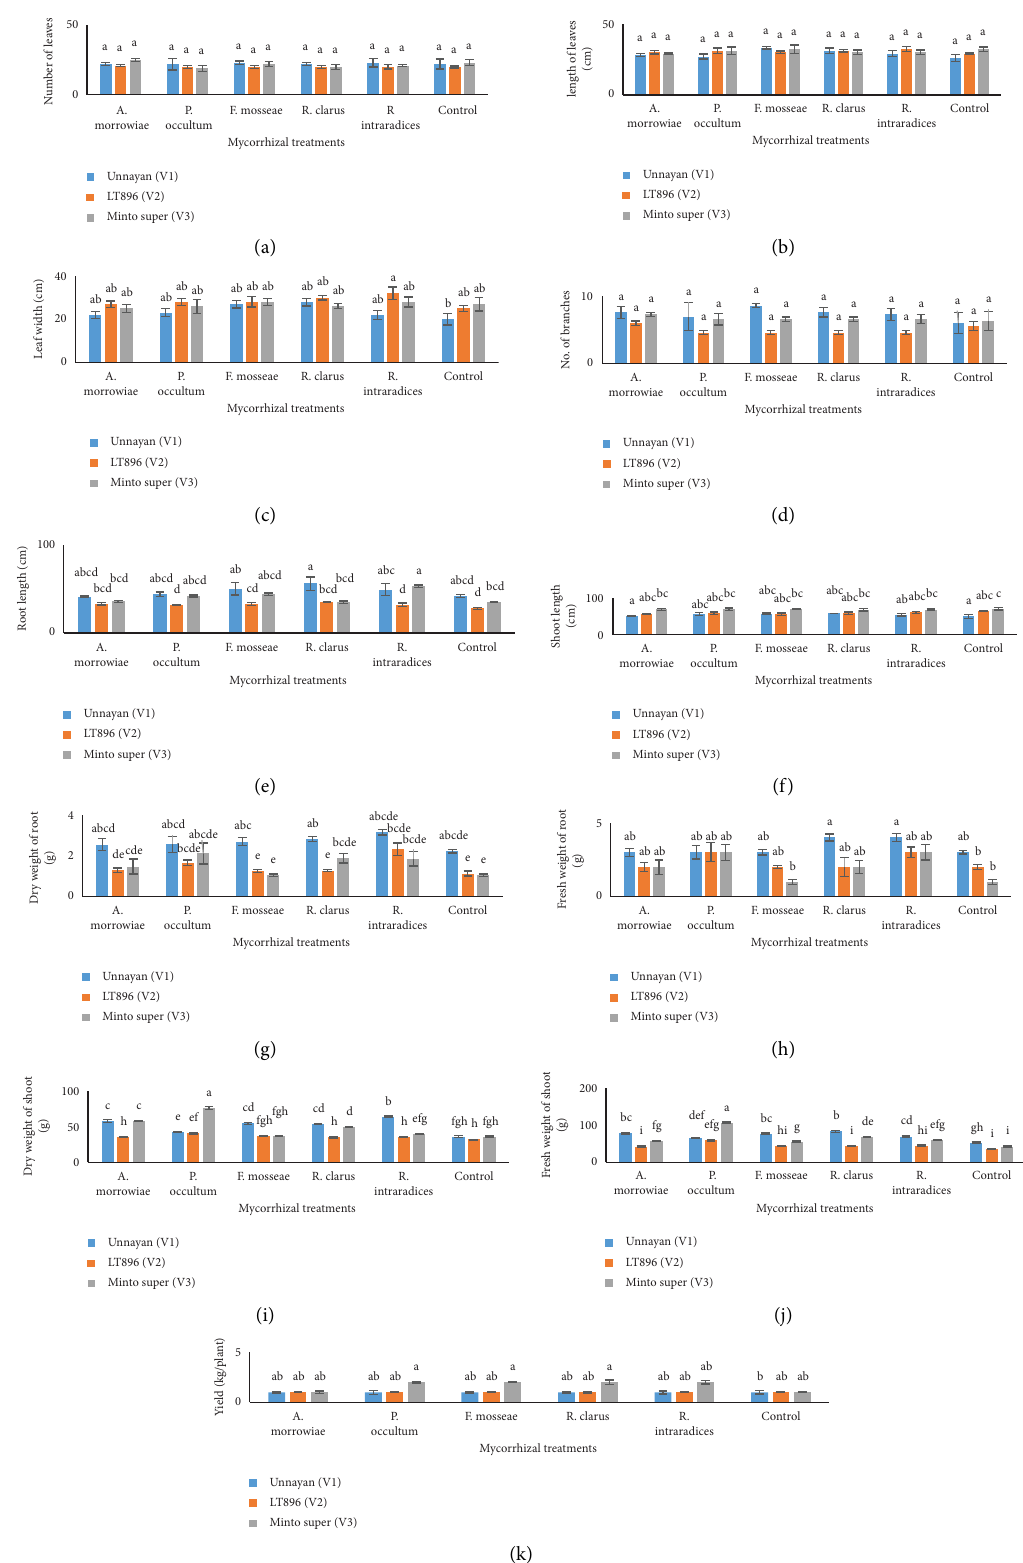
Figure 3: Efect of AMF on (a) number of leaves, (b) length of leaves, (c) leaf width, (d) number of branches, (e) root length, (f) shoot length, (g) dry weight of root, (h) fresh weight of root, (i) dry weight of shoot, (j) fresh weight of shoot, and (k) yield of Unnayan, LT896, and Minto super tomatoes (mean ± SEM) grown in soil under drought condition. Means denoted by diferent letters indicate a diference at 0.05% level of signifcance. Tree varieties, 5 replications, and 5 treatments with one control were used in this